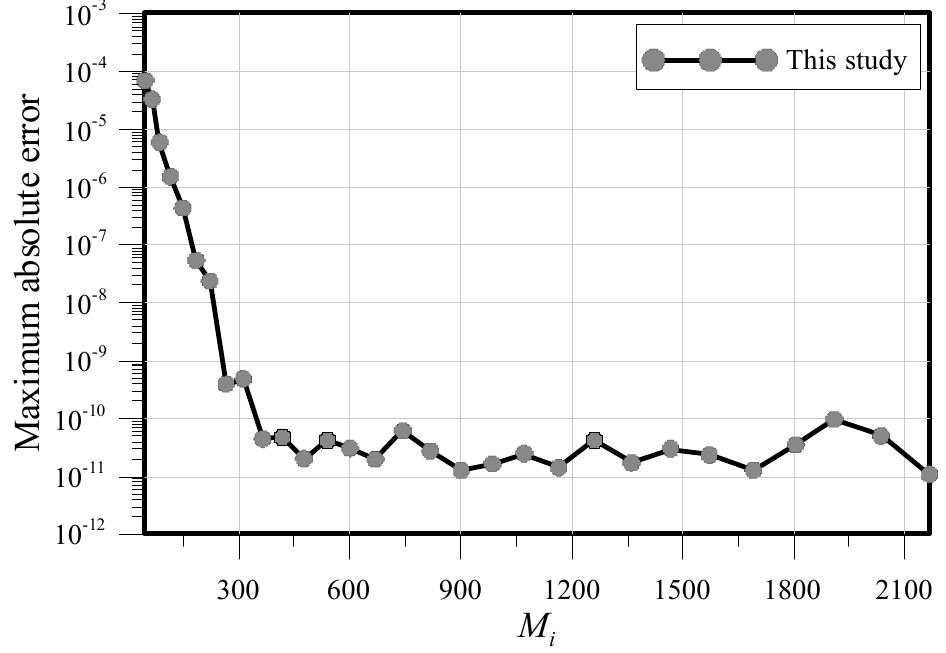
Figure 17. The number of boundary points versus the maximum absolute error.